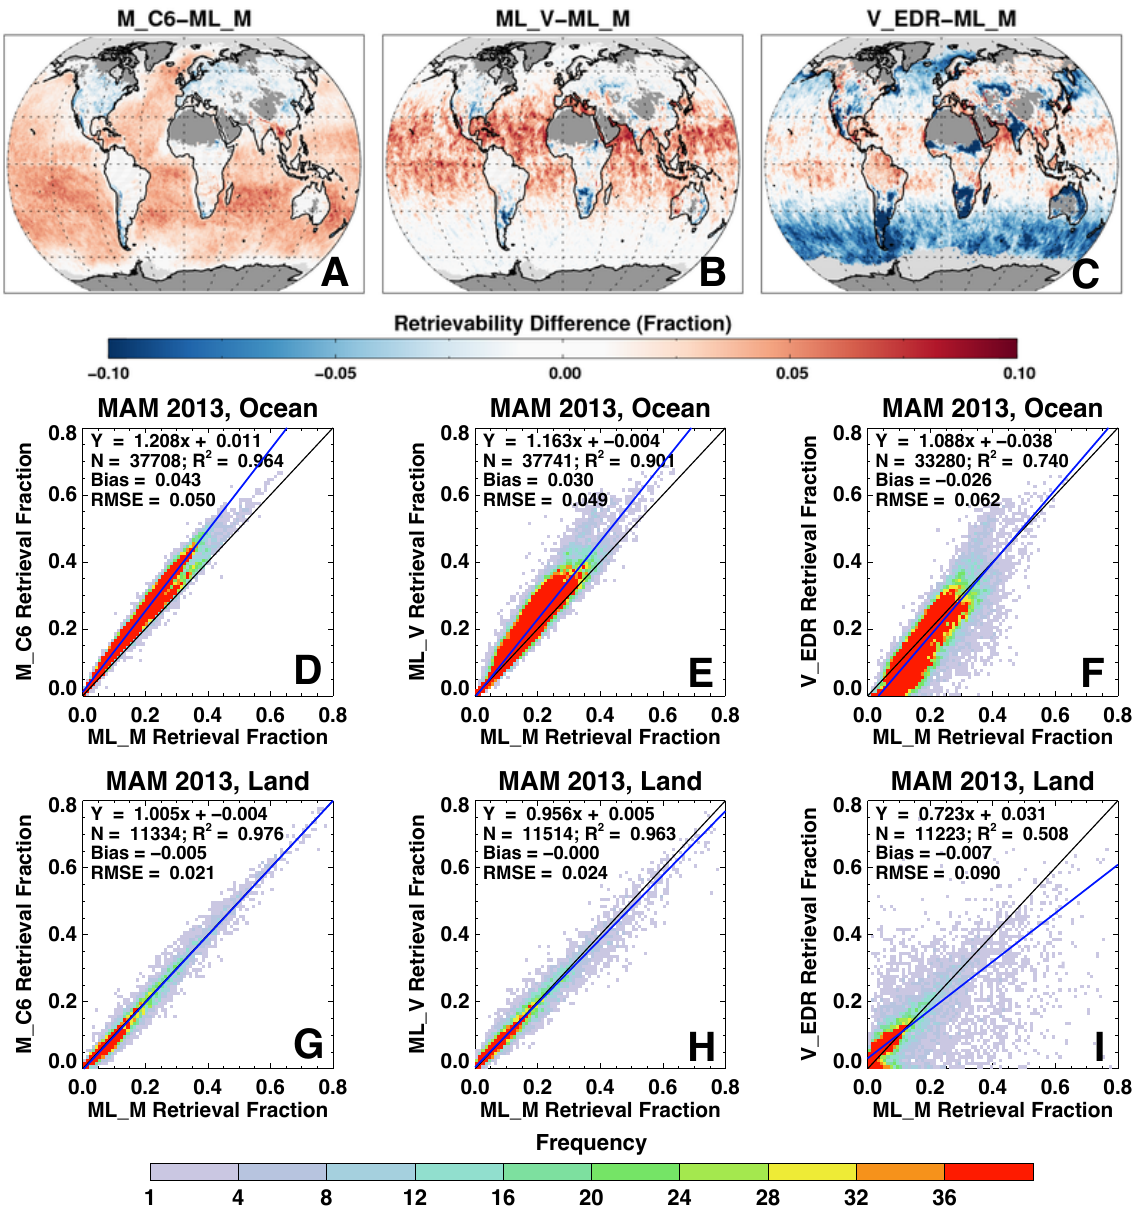
Figure 12. Comparing retrieval fraction between each product and the ML_M product (Fig. 11). The top row (a–c) are difference maps, whereas the bottom two rows ( d–f for ocean and g–i for land) are frequency